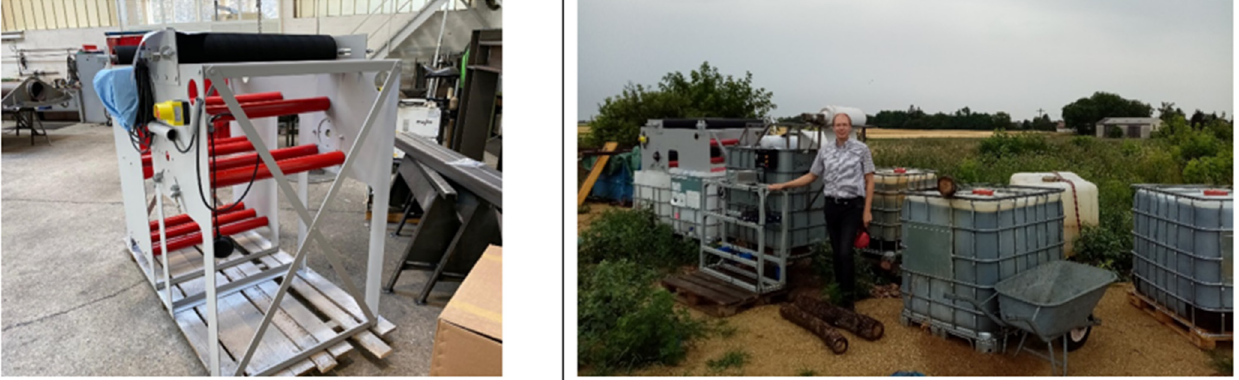
Figure 8. The inclined bed filter (IBF) in the workshop ( left ) and in the field ( right ). In the right picture, two IBCs with mineral hydrocarbons pumped from the ground and separated by the IBF with non-wovens can be seen in the font.